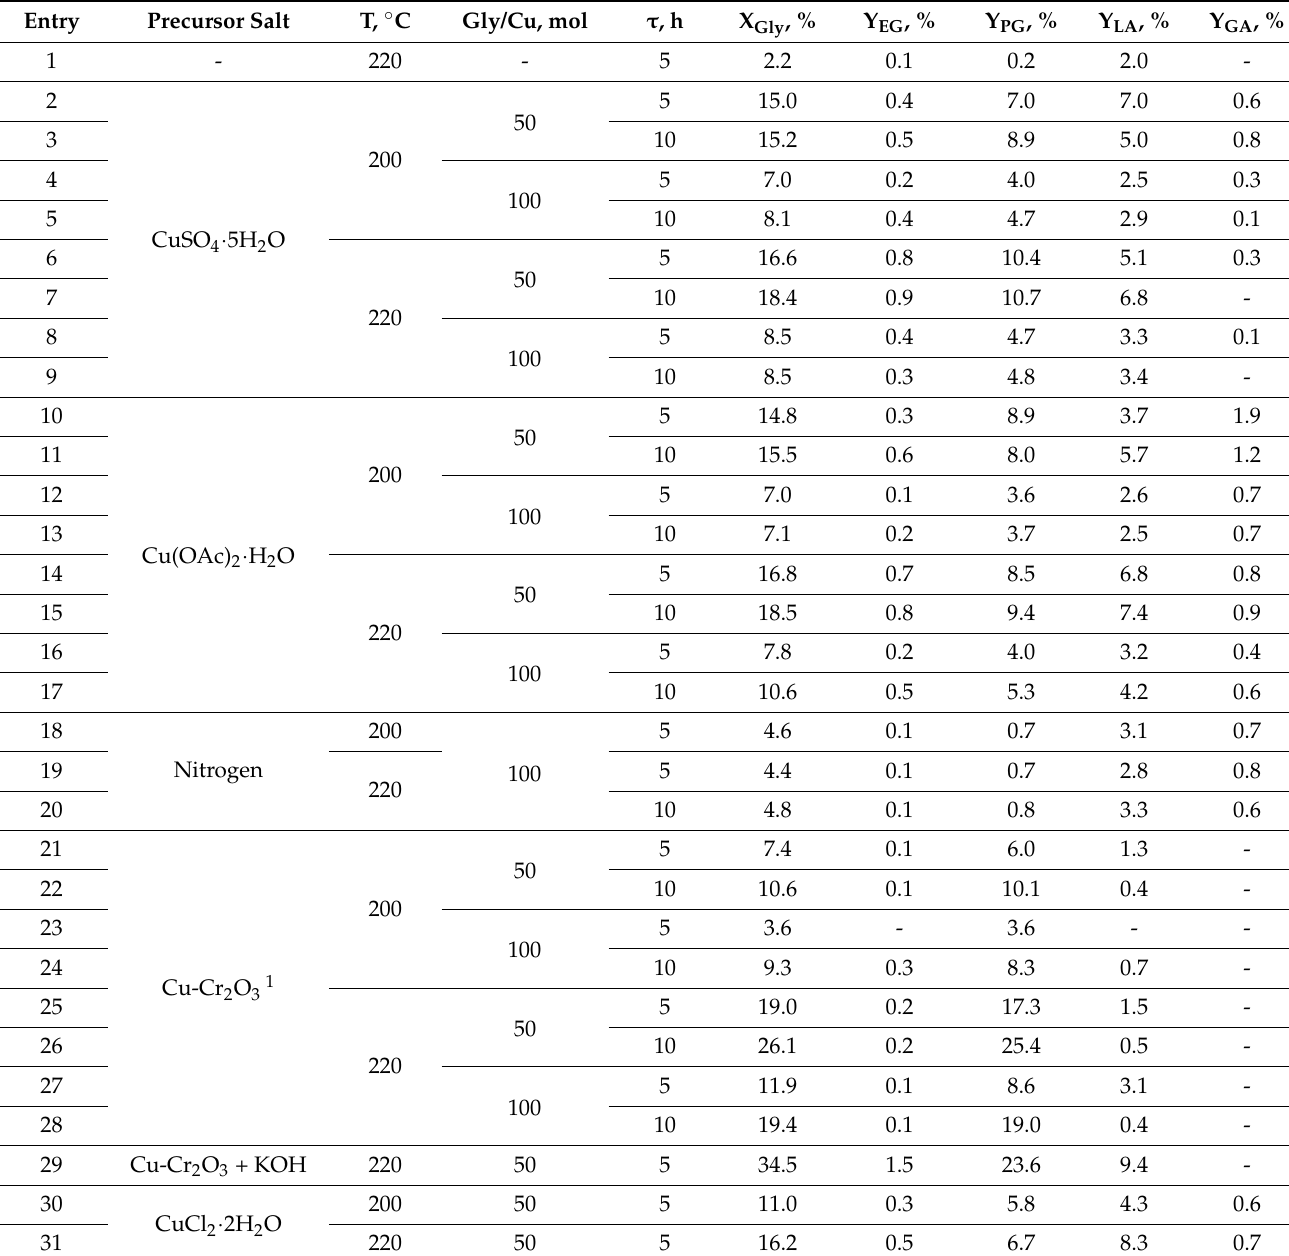
Table 1. Hydrogenolysis of glycerol in the presence of copper catalysts. Conditions: p(H 2 ) = 3